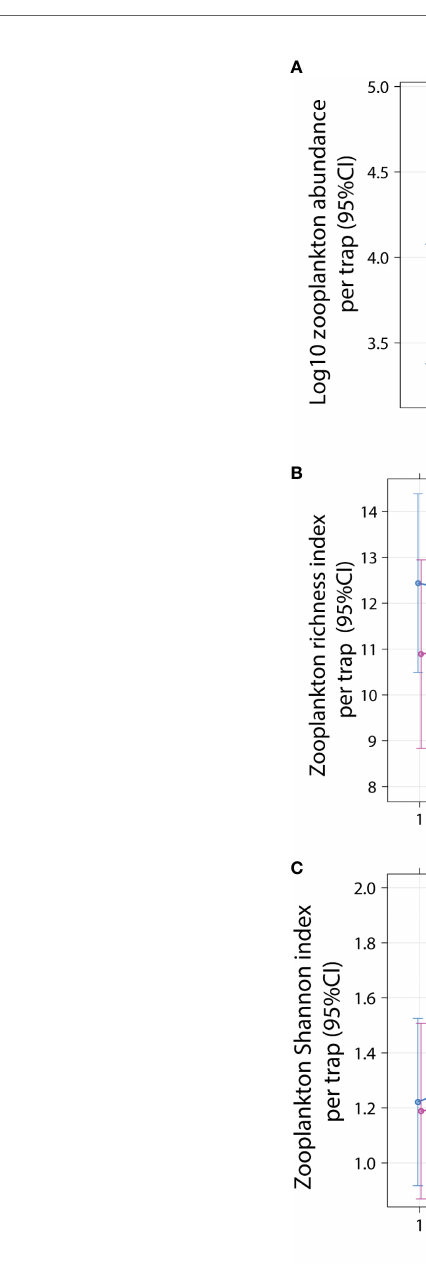
Supplementary Figure 7C; Shannon index: Day: 1.308, 0.160; Night: 1.483, 0.159; mean, 95% CI).